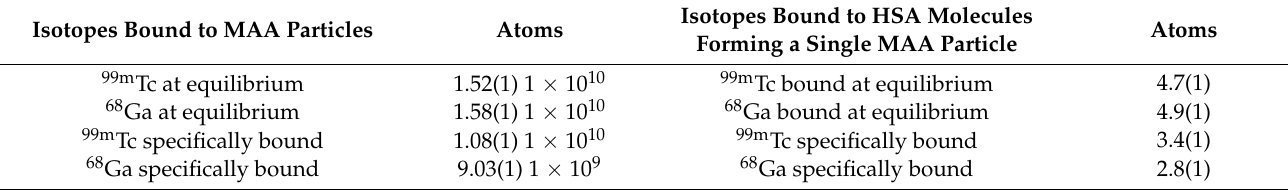
Table 3. Number of 99m Tc and 68 Ga atoms bound to a single MAA particle and then normalised to the human serum albumin molecules contained in each macroaggregate particle (Mean (SD)). Isotopes Bound to MAA